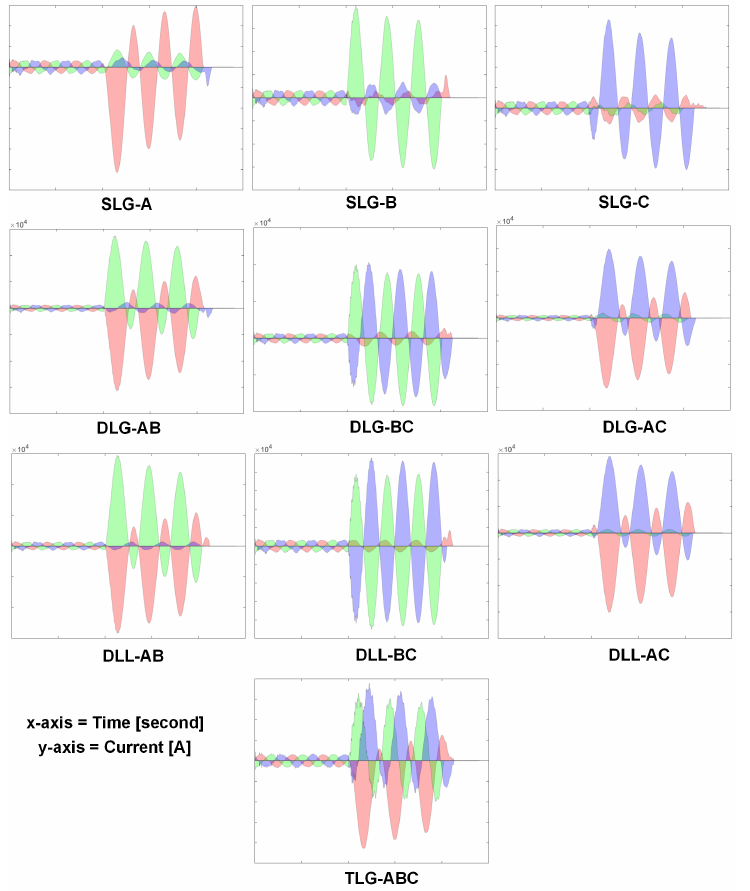
Figure 3. Applying the proposed coloring method for different types of